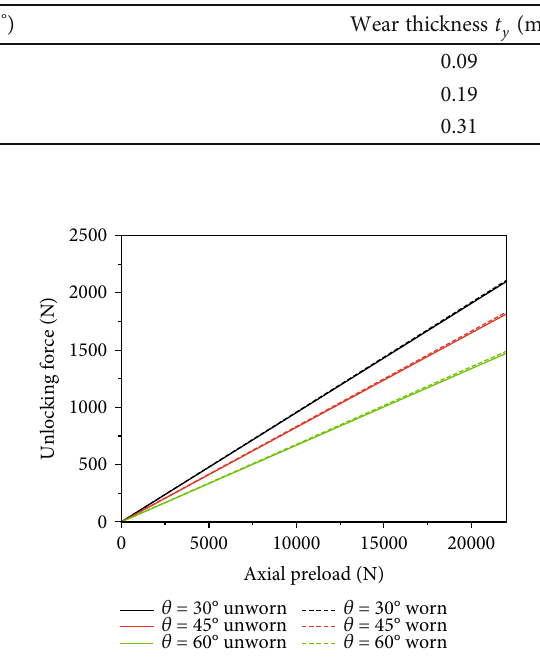
Figure 27: Unlocking force corresponding to di ff erent θ and μ = = 111 : 6 , and Φ = 98 . 0 : 05 , Φ 1 2 Table 9: Wear thickness corresponding to di ff erent Φ